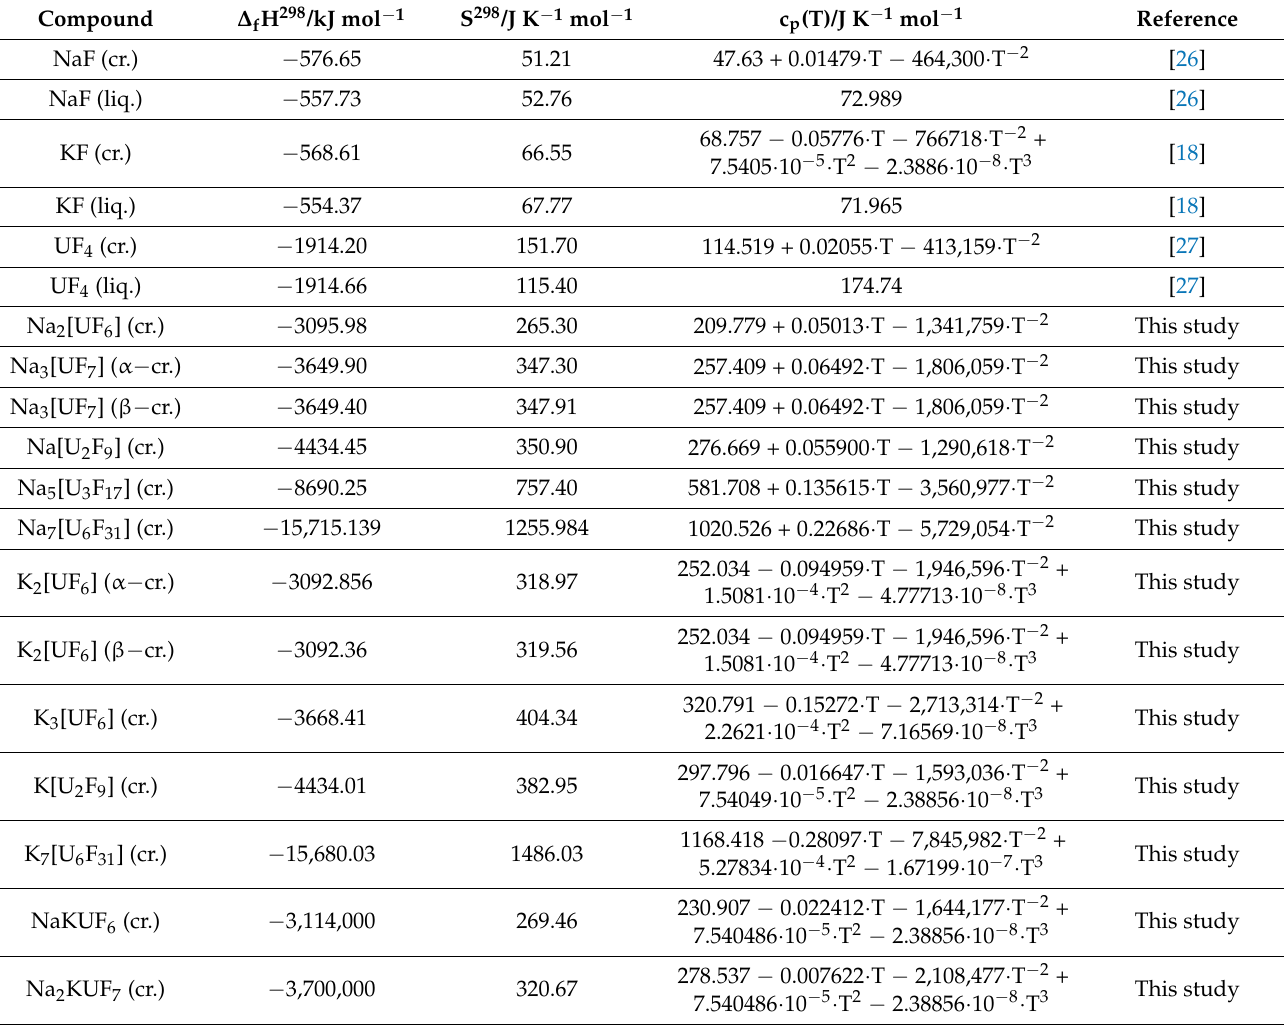
Table 1. Thermodynamic data ( ∆ f H 298 , S 298 , and c p (T)) of the compounds stabilised in the NaF-UF 4 , KF-UF 4 and NaF-KF- UF 4